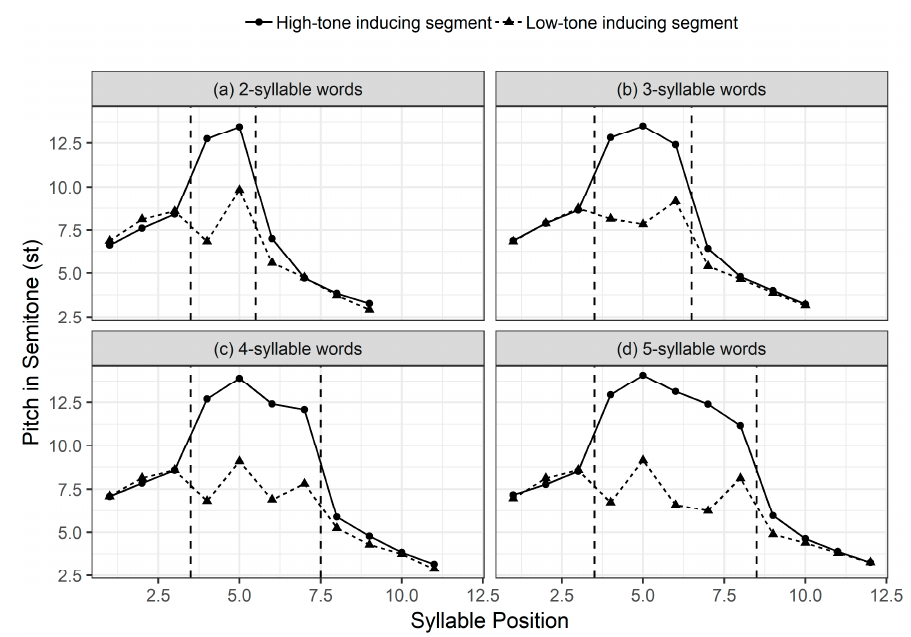
Figure 1. Mean pitch values of all speakers by the length of the target words. The x-axis shows syllable positions in the target sentences, and the y-axis shows the mean pitch values. The first three syllables are for /i.t ɕ e.n ɯ n/ ‘now- TOPIC ’, and the last four syllables are for /mal.ha.se.jo/ ‘say’ in the carrier sentence / i.dʑe.nɯn ____ mal.ha.se.jo/ ‘Now say _____.’, and the syllables in the middle (inside the dashed lines) are the target words. 1 Modified from Cho and Lee (2016).